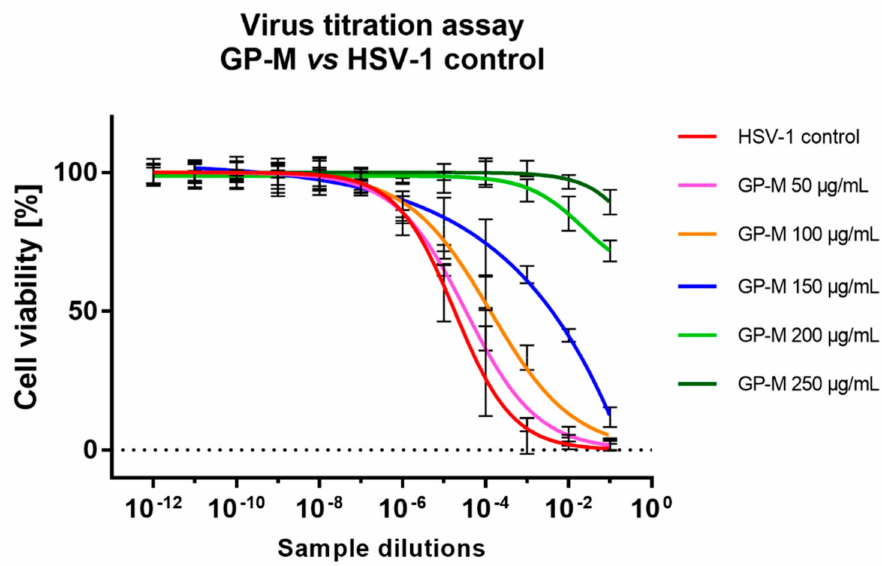
Figure 3. End-point dilution assay of HSV-1 titer in samples treated with Geranium pyrenaicum methanol